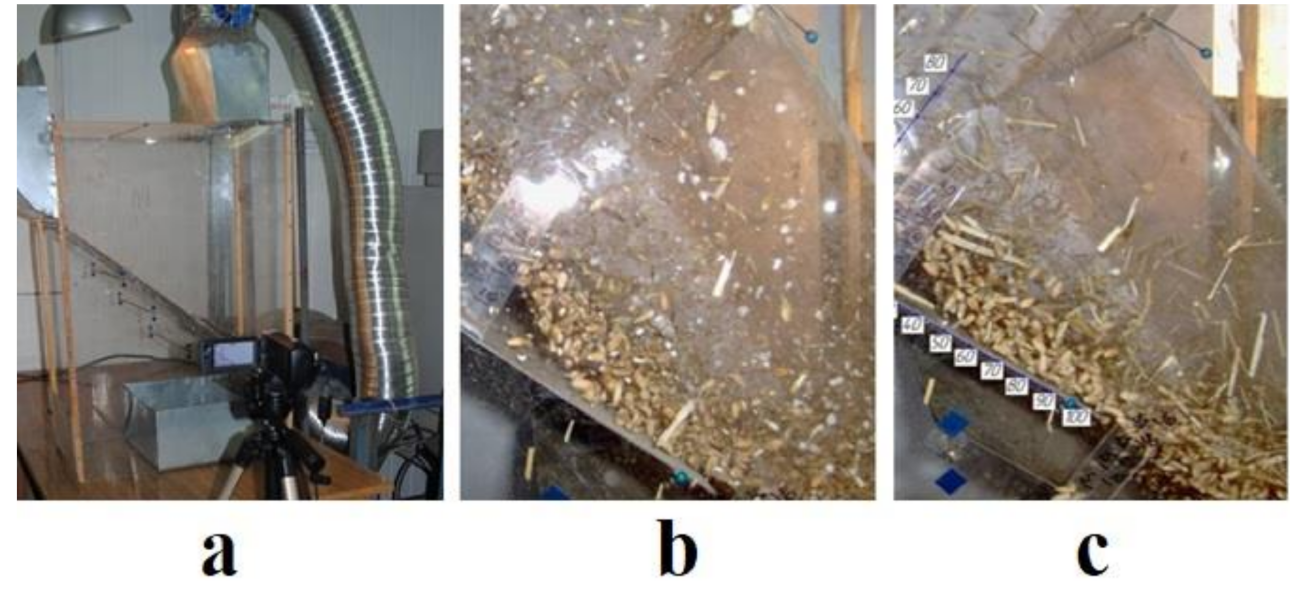
Figure 4. Videography of the dynamics of the components of the grain mixture and photographic images: ( a ) general appearance; ( b ) close-up on a moving layer of grain and impurities; ( c ) markings used for frame-by-frame analysis of photographic